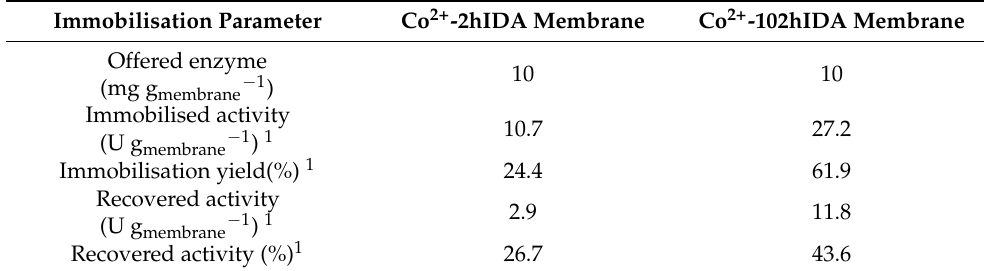
Figure 7. Covalent immobilisation of HeWT on epoxy membranes partially derivatised with metal by two step procedure: (1) affinity binding of his-tagged enzyme molecules to Co 2+ groups, and (2) reaction of adjacent amine groups from lysine residues react with nearby epoxy groups. Table 3. Immobilisation of HeWT on metal-derivatised membranes, Co 2+ -2hIDA- and Co 2+ - 102hIDA membranes.